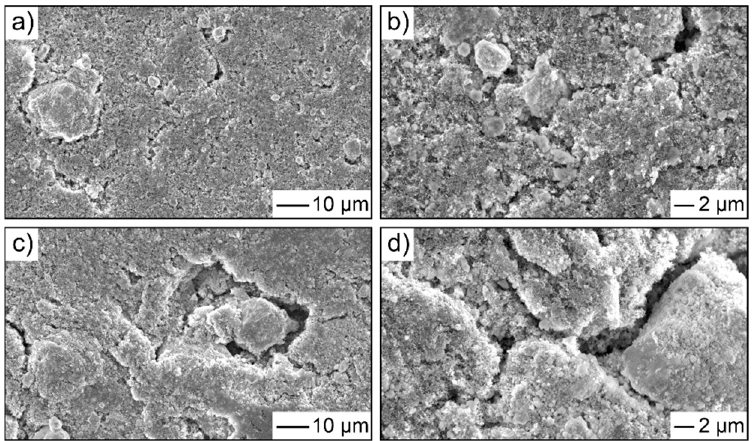
Figure 3. Top-view SEM images at different magnifications of the LiHEOF cathode charged to ( a , b ) 4.6 V and ( c , d ) 5.0 V vs. Li + /Li in the initial cycle. ( a , b ) 4.6 V and ( c , d ) 5.0 V vs. Li + /Li in the initial